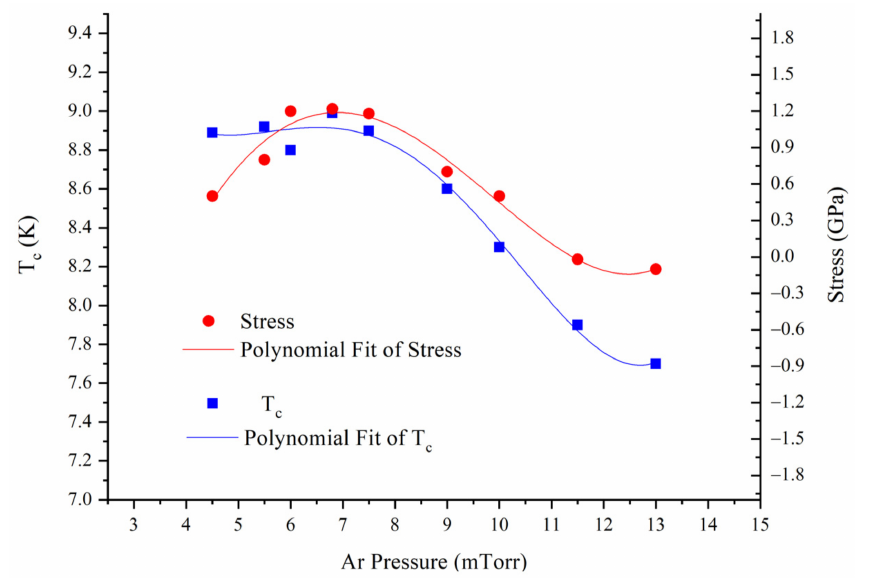
Figure 7. Film stress and Tc versus Ar pressure after the target-to-substrate distance changes to 130